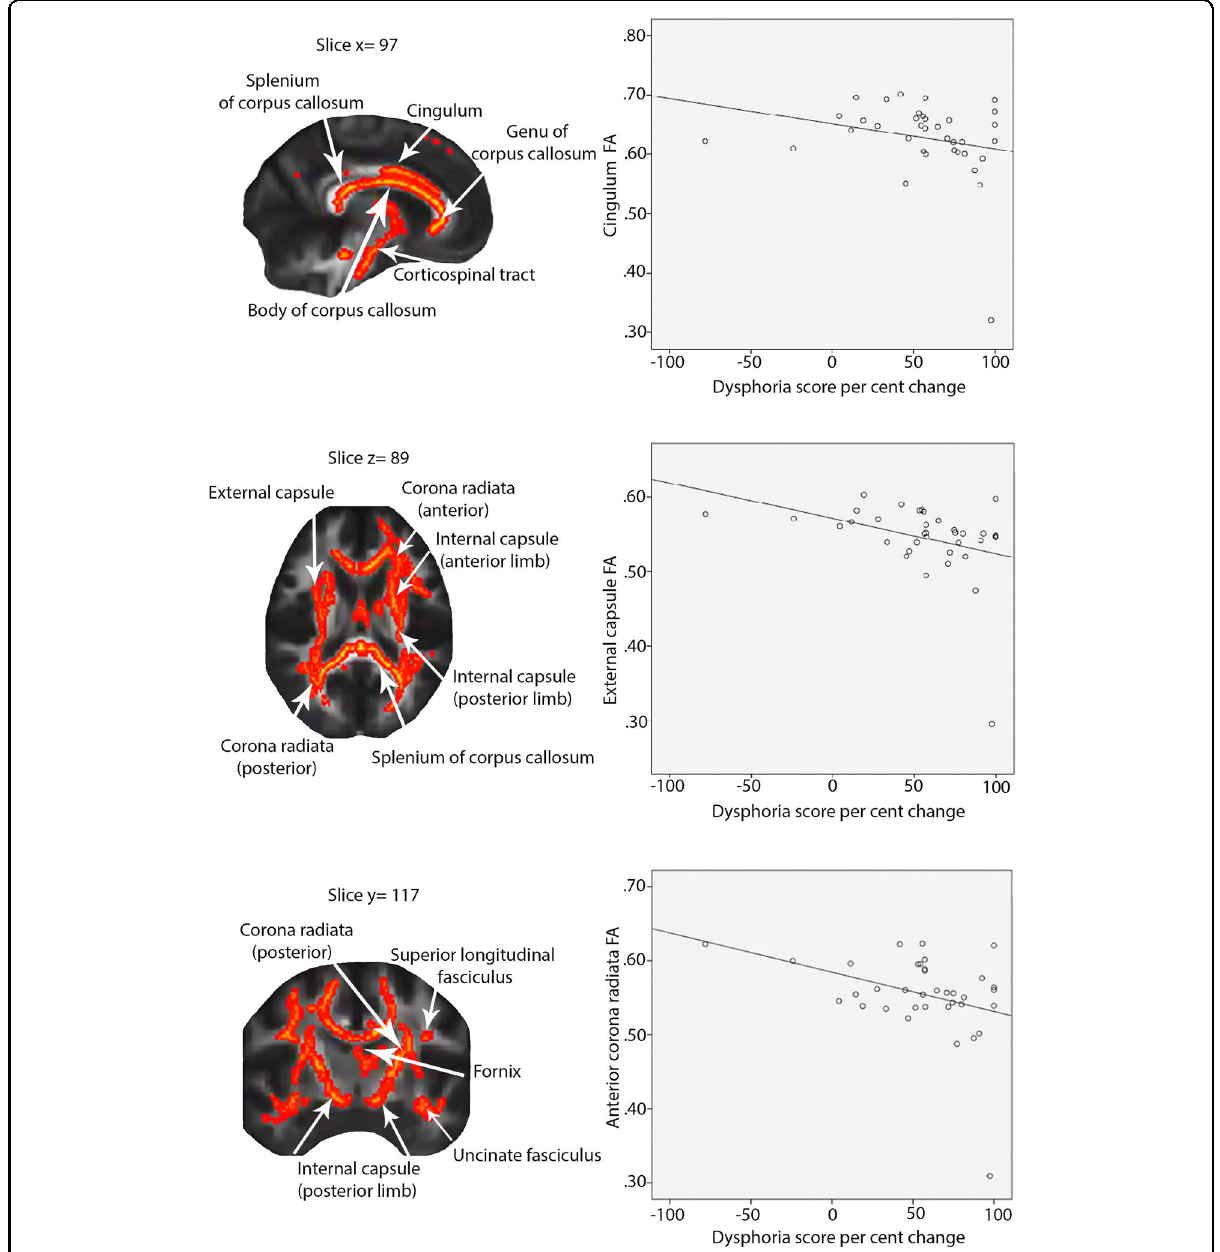
Fig. 1 Signi fi cant white matter clusters for correlation between change in dysphoria score and FA. Clusters are overlaid on a mean fractional anisotropy image. Scatter plots indicate the relationship between FA in a few selected white matter regions with the change in dysphoria PTSD